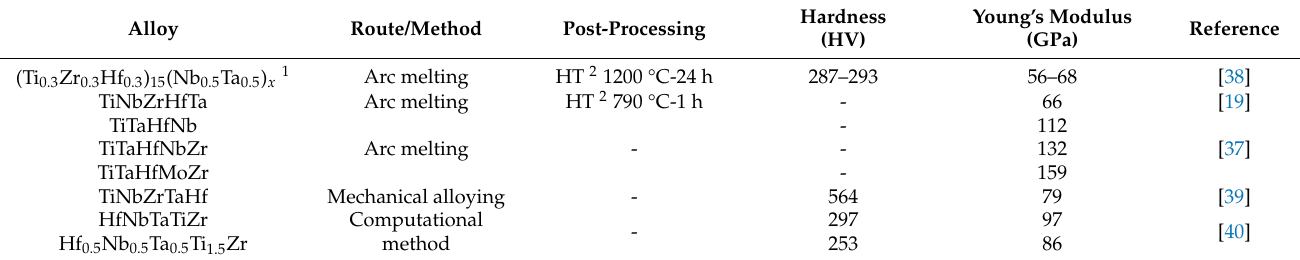
Table 3. Mechanical properties of bioHEAs with single-phase BCC. Alloy